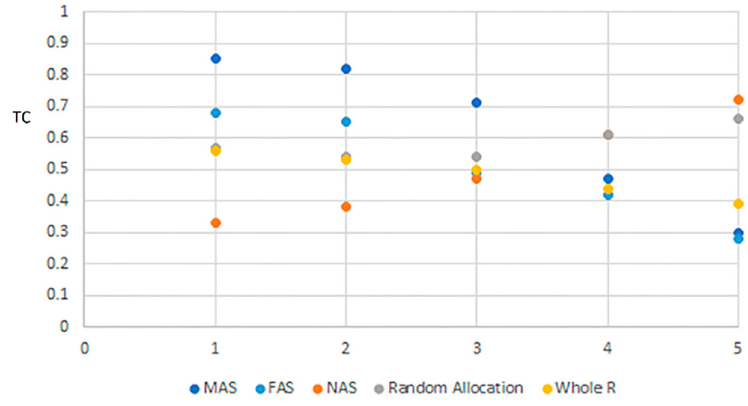
Figure 8. Problem 1, TC minimization in percentage over all scenarios in [7].